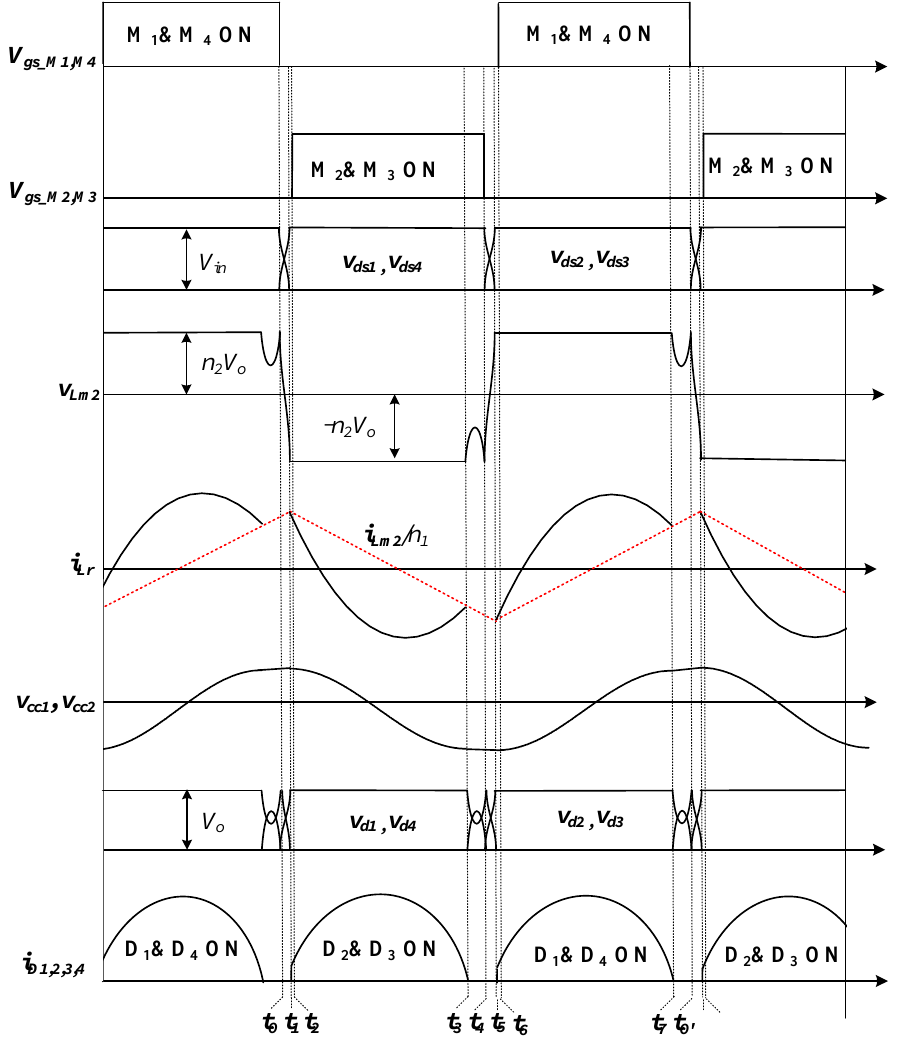
Figure 5. Key waveforms of the proposed CCWPT circuit.